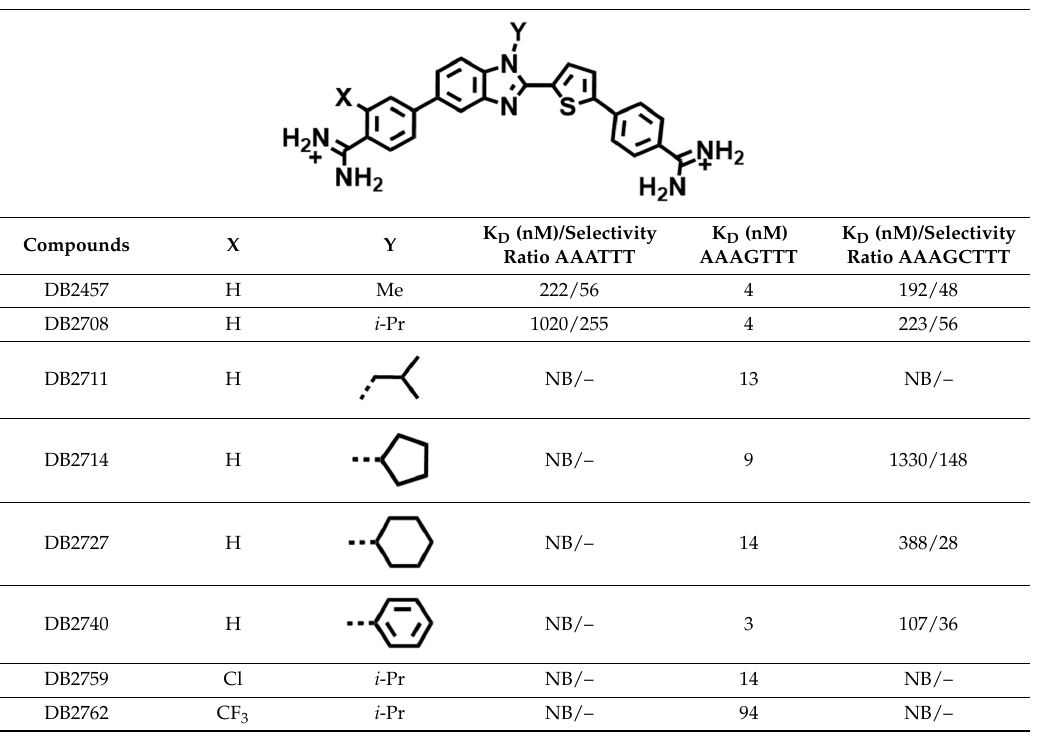
Table 1. Summary of binding affinity (K D , nM) for the interaction of representative compounds with biotin-labeled DNA sequences using biosensor-SPR method a .